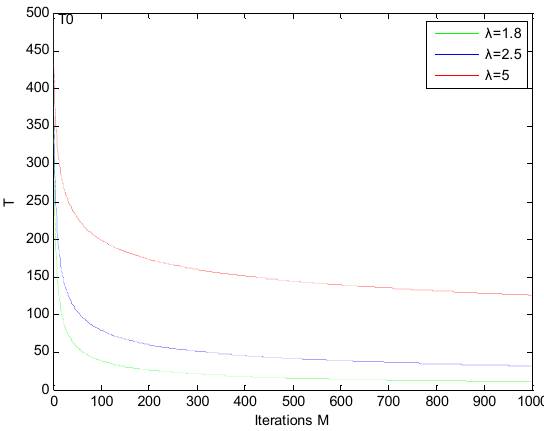
Figure 10. Profile of T variation .